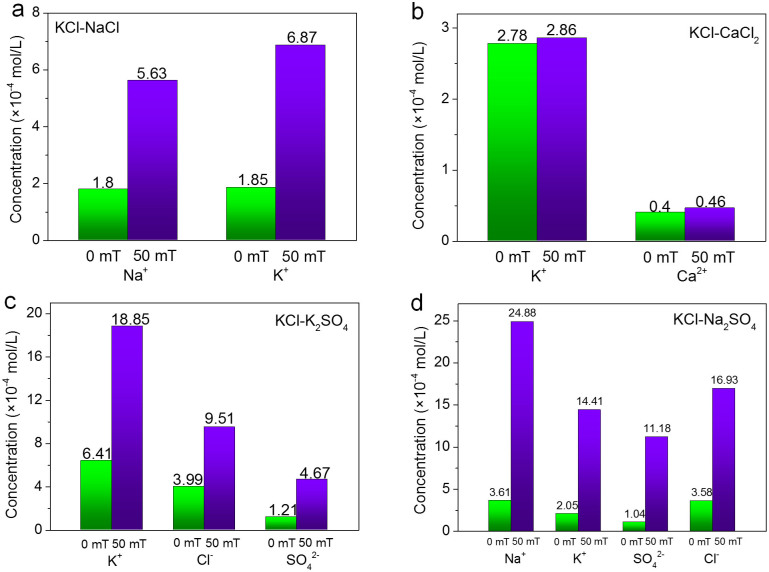
Ion concentrations of the drains during the penetrations of (a) KCl-NaCl, (b) KCl-CaCl2, (c) KCl-K2SO4 and (d) KCl-Na2SO4 hybrid sources when applying magnetic fields (drain to source).